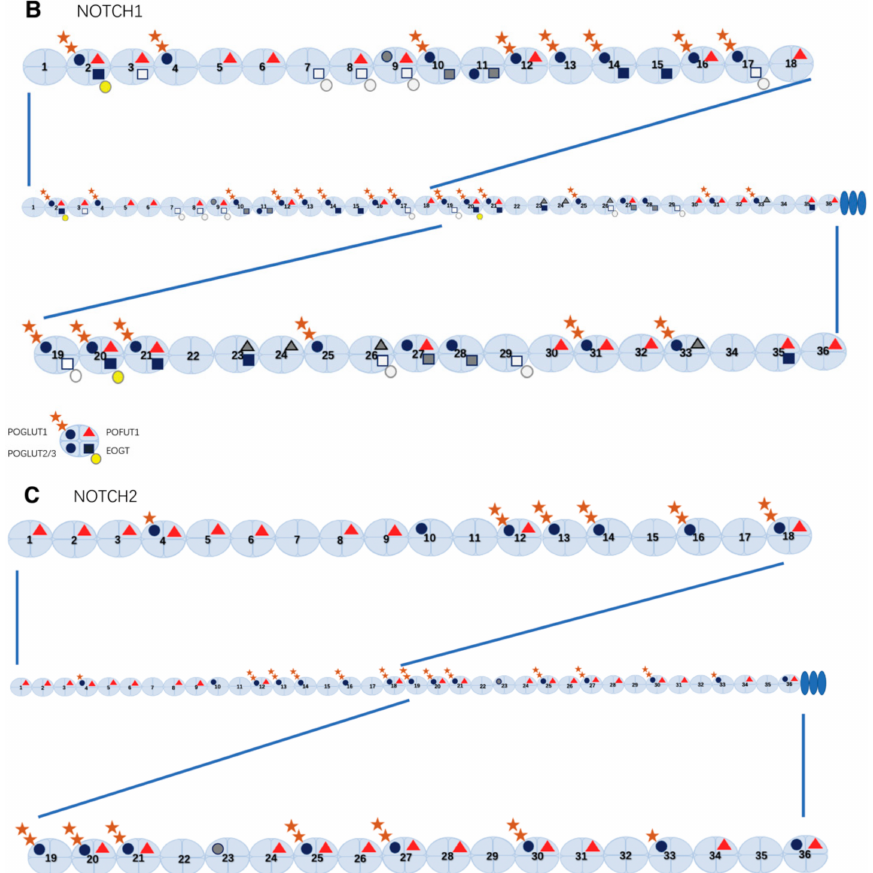
Figure 2. O -Glycosylation in the Notch EGF repeats. ( A ) O -Glycosylation on single EGF re- peats. The EGF repeats can be modified with O -glycans at distinct sites. The three major types of O -linked glycosylation found on the EGF repeats of Notch pathway components are O -fucosylation, O -glucosylation, and O - N -acetylglucosamine (GlcNAc) modification, which exist as monosaccharides or extended forms. O -Fucose monosaccharides are added to a serine or threonine residue within the consensus sequence, C 2 -X-X-X-X-(S/T)-C 3 , and can be elongated with GlcNAc residues by a Fringe family GlcNAc-transferase. O -Glucose monosaccharides are added by protein O -glucosyltransferase (POGLUT)-1 to a serine residue within the consensus sequence, C 1 -X-S-X-(P/A)-C 2 , and can be further elongated to xylose-glucose- O disaccharides and xylose-xylose-glucose- O trisaccharides by glucoside α -1,3-xylosyltransferases (GXYLT) and xyloside α -1,3-xylosyltransferase-1 (XXYLT1). O -Glucose monosaccharides are added by POGLUT2 or POGLUT3 to a serine residue within the consensus sequence, C 3 -X-N-T-X-G-S-F-X-C 4 . O -GlcNAc monosaccharides are added to a serine or threonine residue within the consensus sequence, C 5 -X-X-G-X-(S/T)-G-X-X-C 6 , and can be modified with galactose and sialic acid in mammals. ( B ) Schematic of O -glycosylation sites on EGF repeats in the ECD of mouse NOTCH1. Data are from references [12,22,23]. Grey-colored sugar indicates that the predicted site appears to be unmodified, and white-colored sugar indicates that data for that site are not yet available. ( C ) Schematic of O -glycosylation sites on EGF repeats in the ECD of mouse NOTCH2. Data are from ref [12,24]. Grey-colored sugar indicates that the predicted site appears to be unmodified, while white-colored sugar indicates that data for that site are not yet